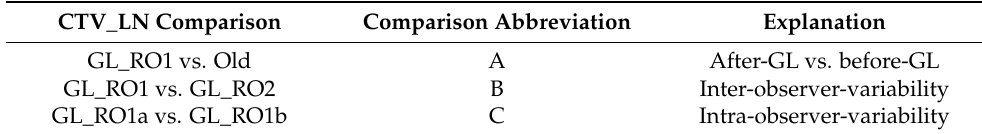
Table 2. Scheme of the comparisons performed in this study. CTV_LN Comparison Comparison Abbreviation Explanation GL_RO1 vs. Old A After-GL vs. before-GL GL_RO1 vs. GL_RO2 B Inter-observer-variability GL_RO1a vs. GL_RO1b C